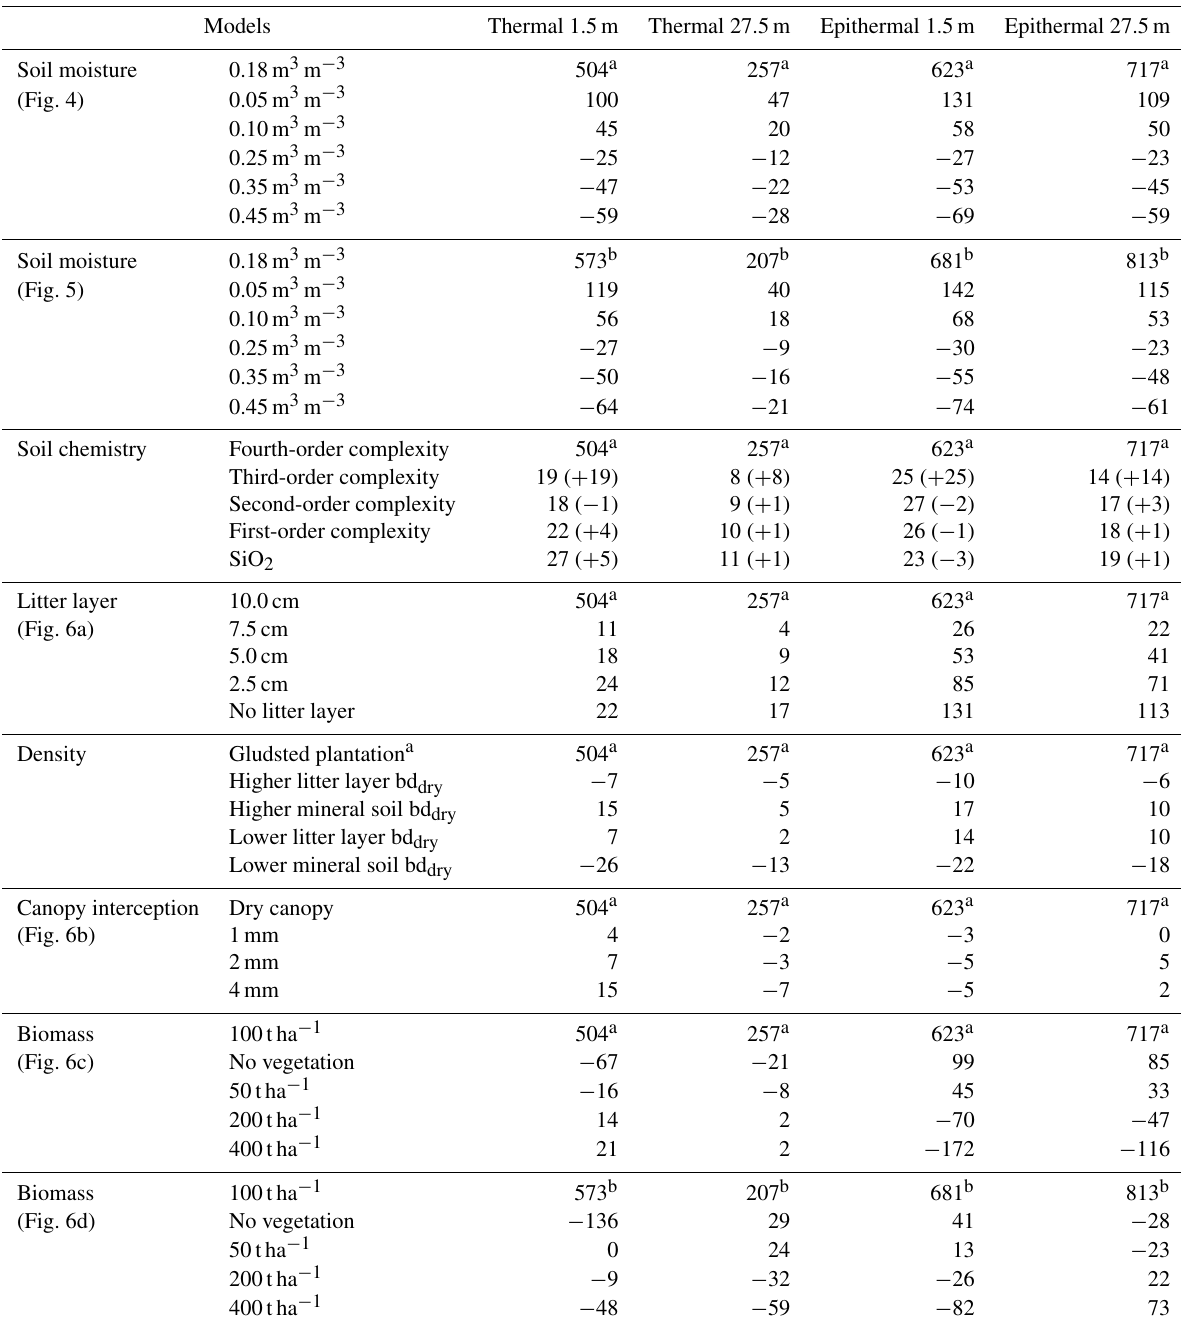
Table 6. Sensitivity in modeled ground-level (1.5m) and canopy-level (27.5m) thermal neutron intensity and epithermal neutron intensity due to (1) volumetric soil moisture, (2) soil chemistry, (3) litter-layer thickness, (4) mineral soil and litter dry bulk density (bd dry ) , (5) canopy interception and (6) biomass. The sensitivity is provided in absolute values and are relative to the simulations based on model tree trunk, foliage, air a and model foliage b , (see Fig. 3 and Table 5). Values provided in parentheses specifies the direct effect of one-by-one excluding soil organic matter (third-order complexity), Gd (second-order complexity), belowground biomass (first-order complexity) and site-specific major elements soil chemistry (SiO 2 )